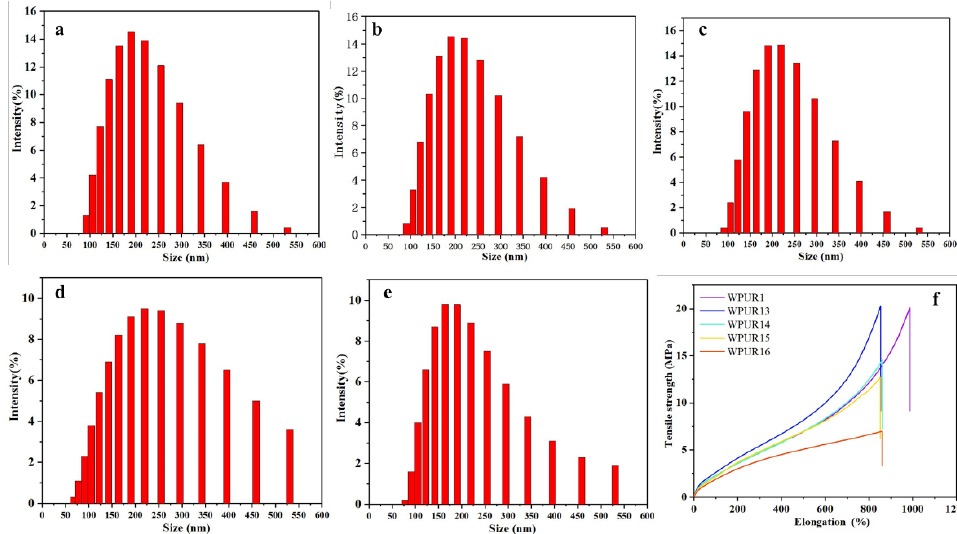
Figure 4. The particle sizes and distribution of WPUR1 ( a ), WPUR13 ( b ), WPUR14 ( c ), WPUR15 ( d ) and WPUR16 ( e ), respectively. ( f ) Tensile properties of different WPURs at ratio of EDA:H 2 O = 1:5 (WPUR1), 1:4 (WPUR13), 1:3 (WPUR14), 1:2 (WPUR15) and 1:1 (WPUR16), respectively.